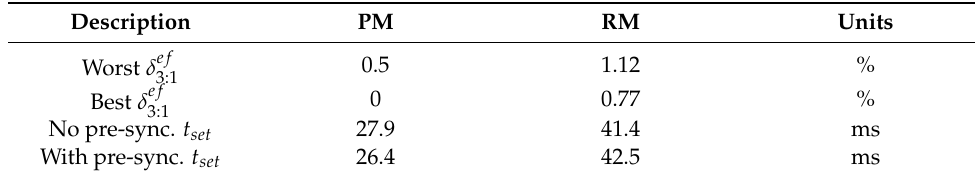
Table 8. Results